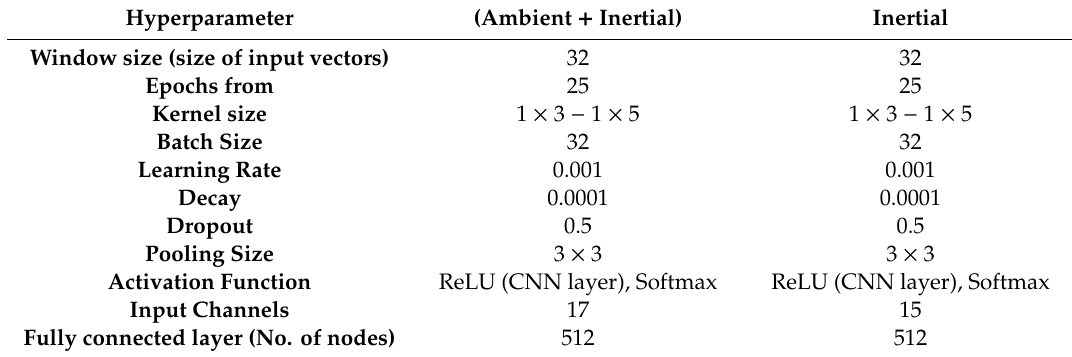
Table 1. Experiment